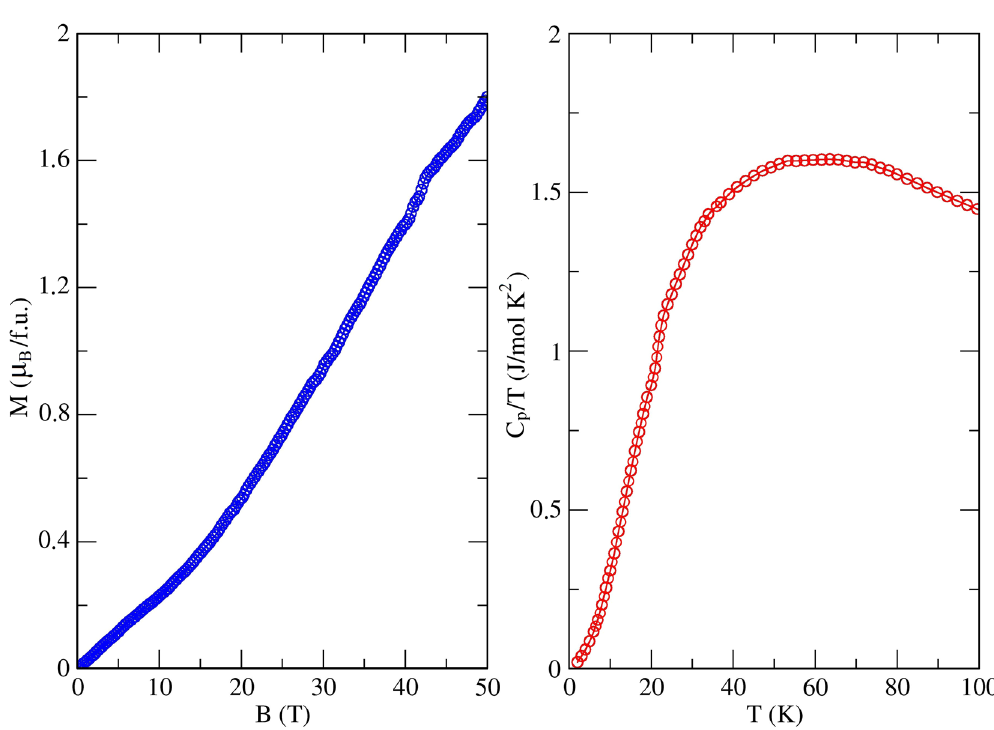
Figure 4. (Left panel) The magnetization curve measured at T = 1.5 K. (Right panel) Temperature dependence of the specific heat, C p ( T )/ T , for KCu 5 O 2 (SeO 3 ) 2 Cl 3 measured in zero field.